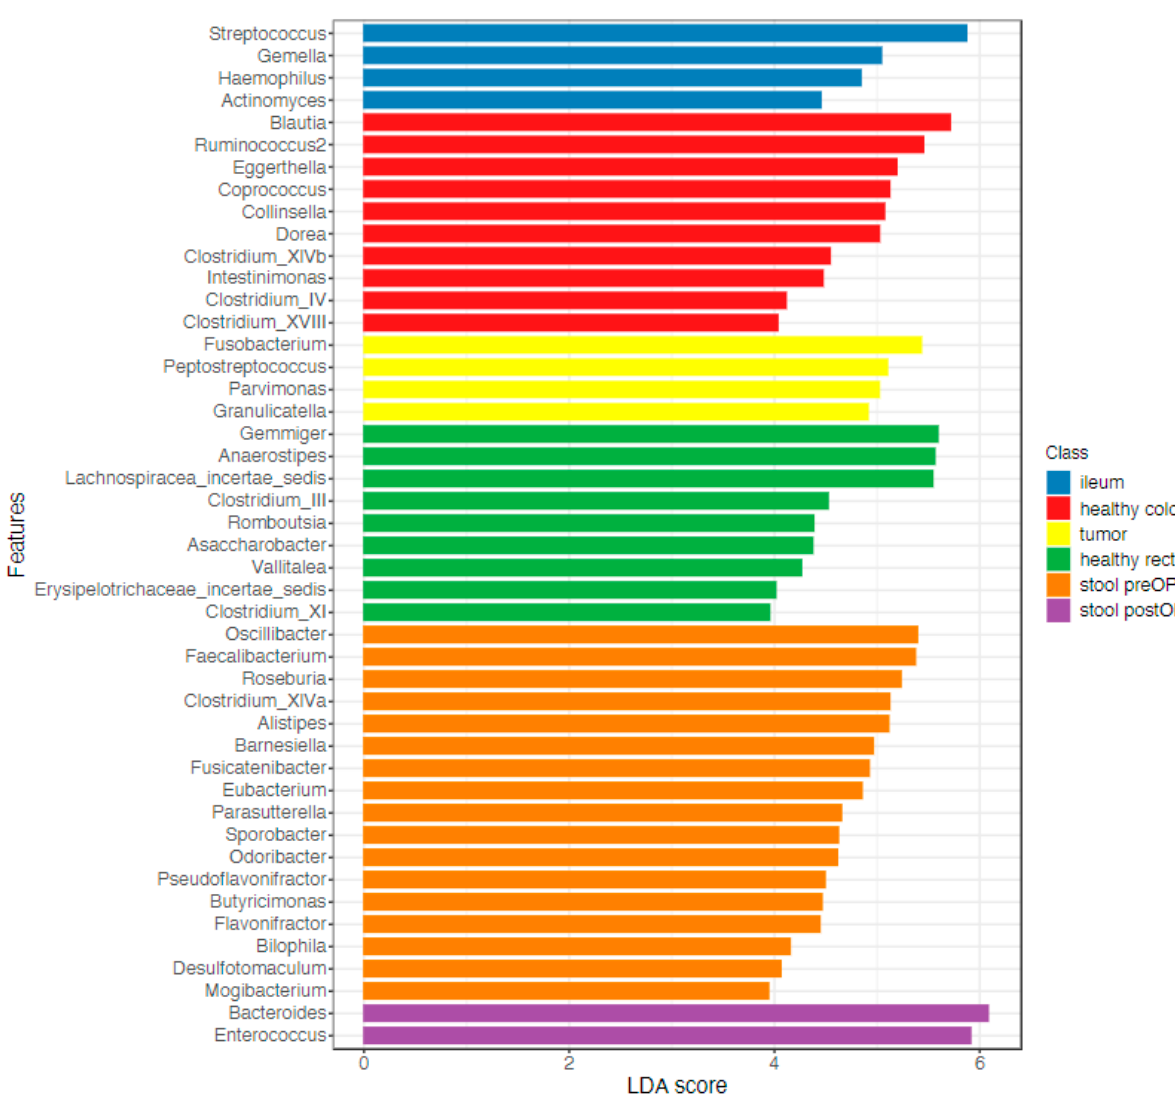
Figure 3. Microbiome communities are significantly different between the locations: LEfSe analysis computed from genera differentially abundant in the analyzed microhabitats, p value < 0.05.